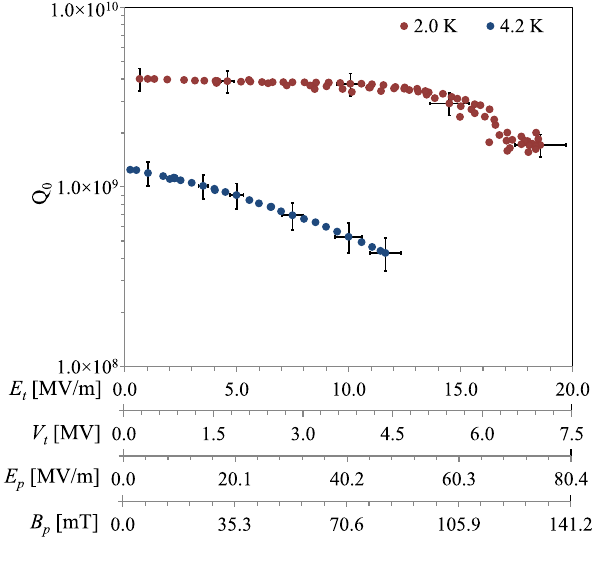
FIG. 11. Quality factor at 4.2 and 2.0 K rf